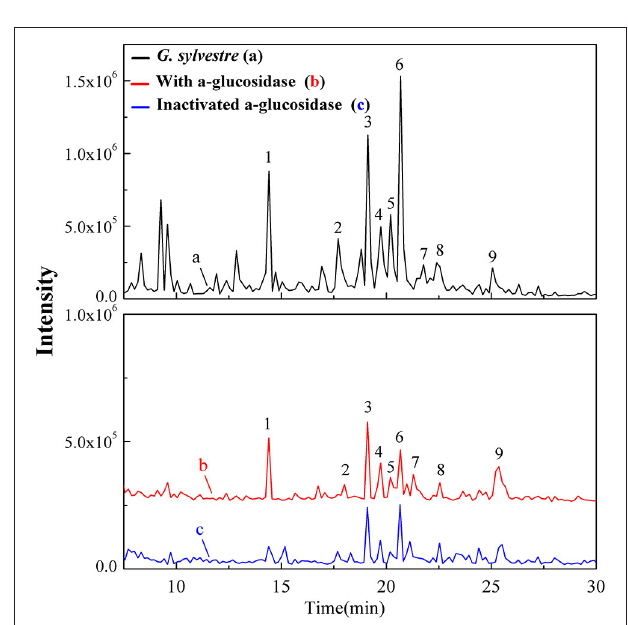
FIGURE 2 | The total ion chromatograms for the UF-HPLC-MS screening of the chemical constituents in the G. sylvestre . The black solid line (a) represents HPLC profiles of the extract of G. sylvestre without ultrafiltration; and the red line (b) and blue line (c) represent HPLC profiles of the G. sylvestre with activated and inactivated Top I,